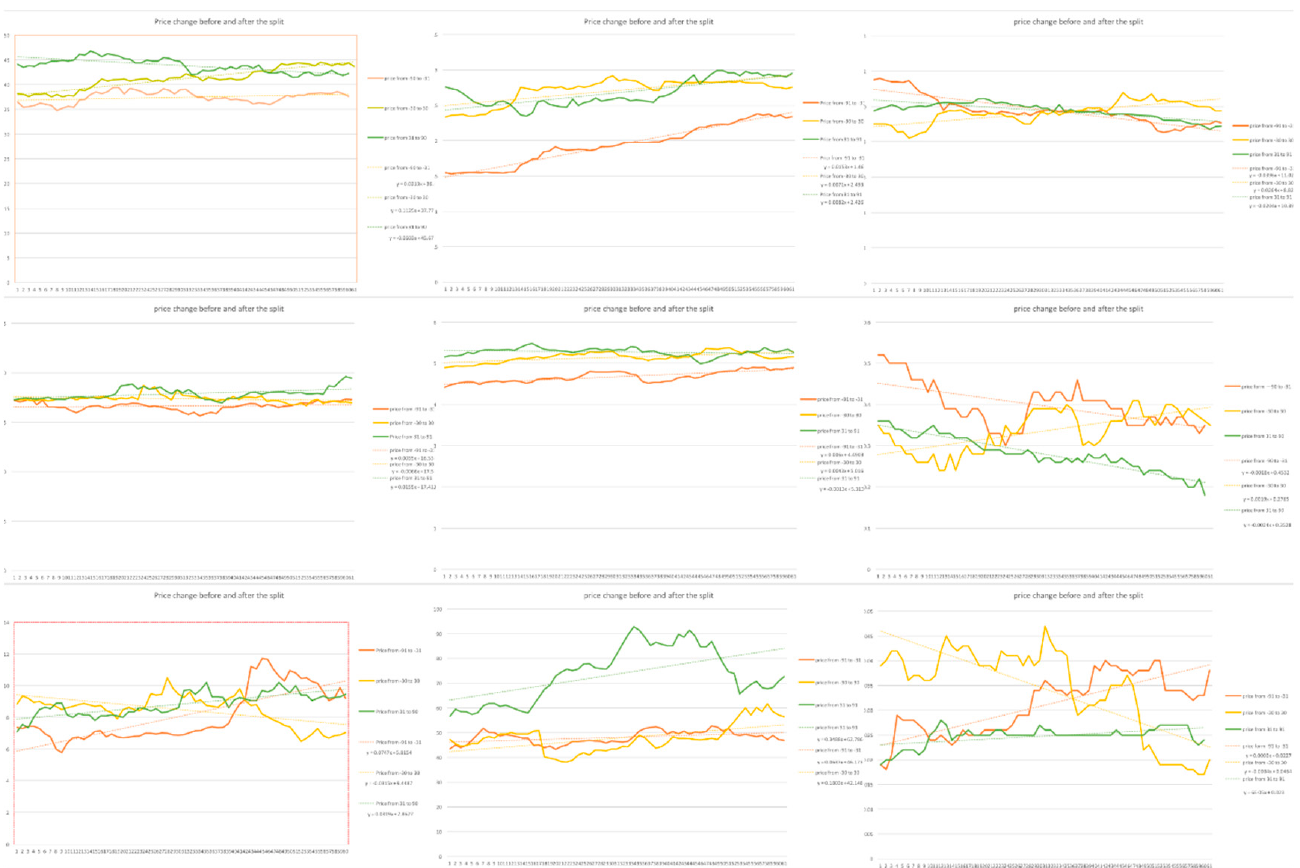
Figure 5 . Price change from day − 91 to day +91 across split date. Red lines represent stock price